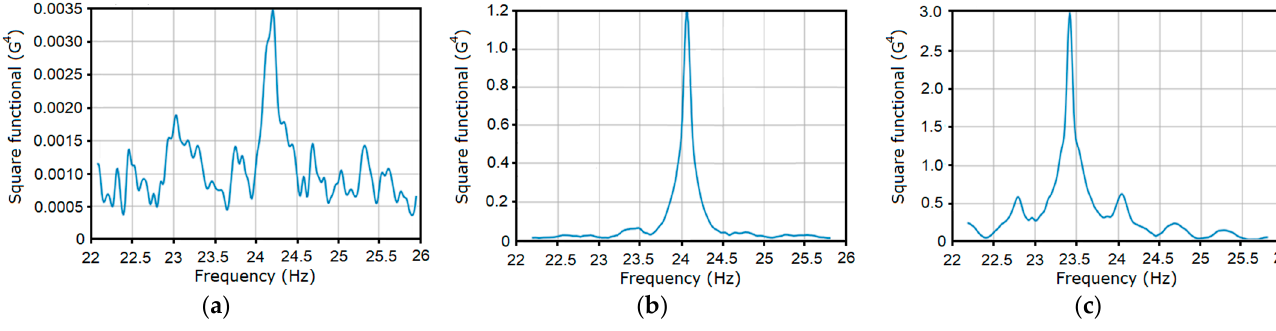
Figure 12. The dependences of the second order square functional (38) on the test period for the first ( a ), the second ( b ) and the third ( c ) stages.